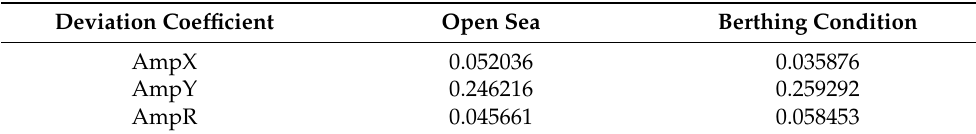
Table 2. Dispersion coefficients of motion response.